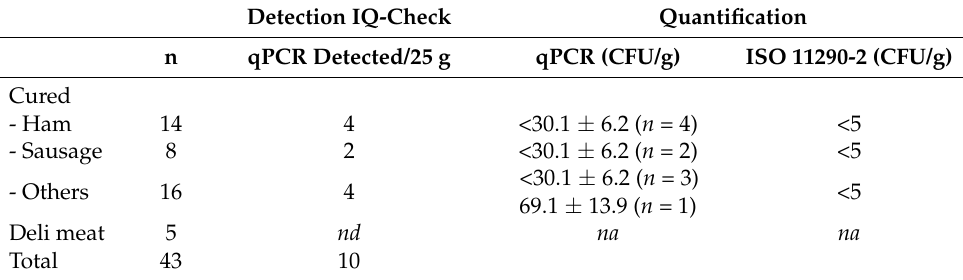
Table 5. Detection and quantification of L. monocytogenes in different commercial meat